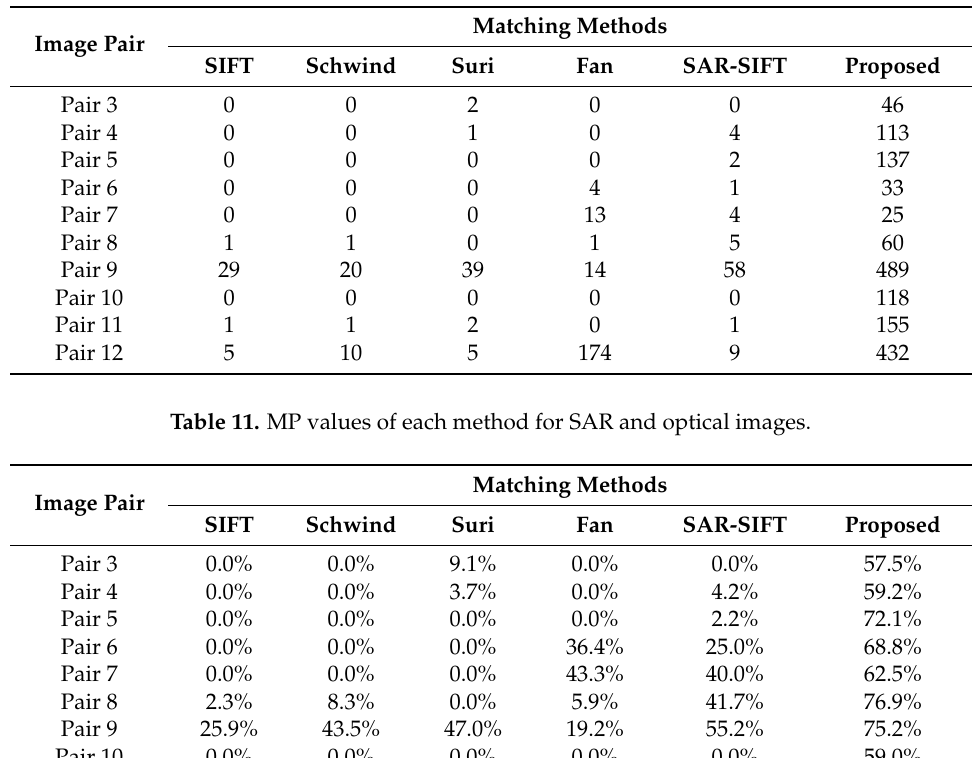
Table 10. NCM values of each method for SAR and optical images.